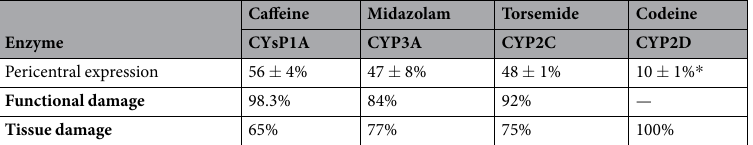
Table 1. Relative pericentral expression (mean ± SD, N = 3), functional damage and tissue damage for CYP1A, CYP3A, CYP2C and CYP2D, metabolizing caffeine, midazolam, torsemide and codeine, respectively. * The staining data for CYP2D was not used in the analysis since the fraction of codeine which is metabolized through this enzyme is™